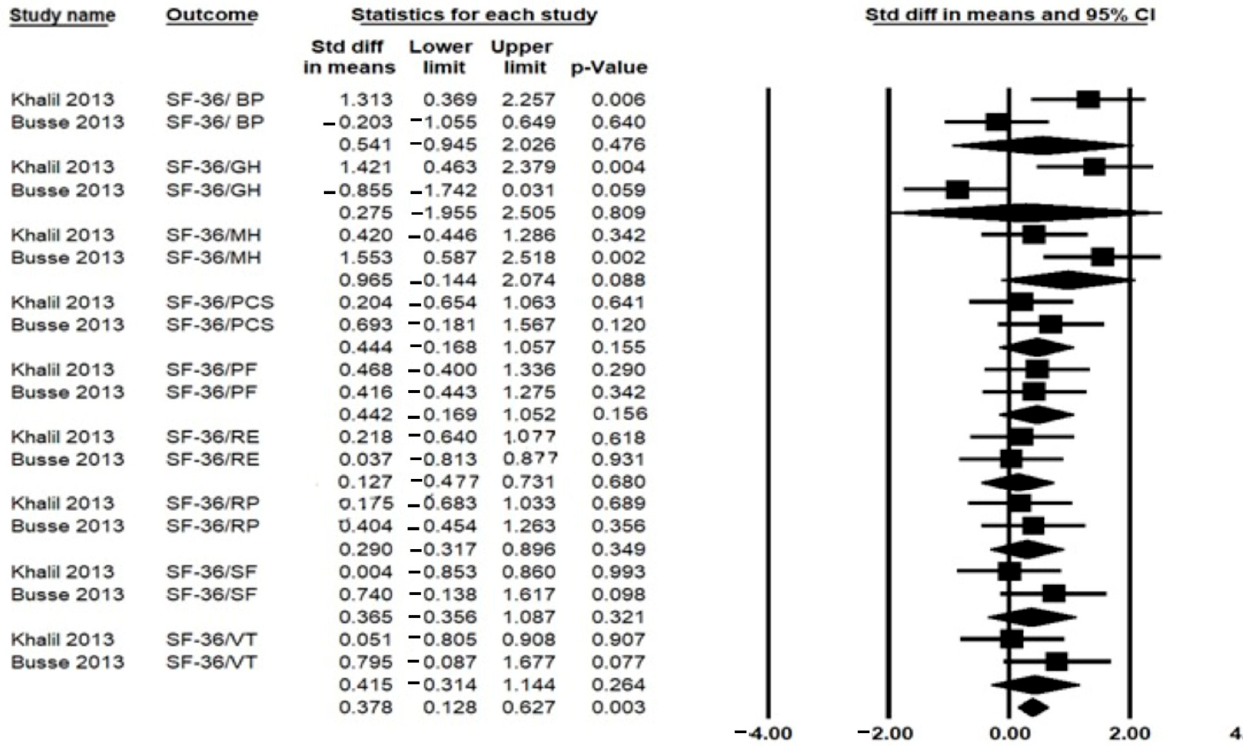
Figure 4. Forest plot for the effects of Home-based exercise (HBE) intervention compared with conventional interventions on quality of life [9,10] measured by SF-36: 36-Item Short Form Health Survey. BP: Bodily Pain; GH: General Health Perception; MCS: Mental Component Summary; MH: Mental Health; PCS: Physical Component Summary; PF: Physical Functioning; RE: Role limited due to emotional problems; RP: Role limited due to physical problems; SF: Social Functioning.